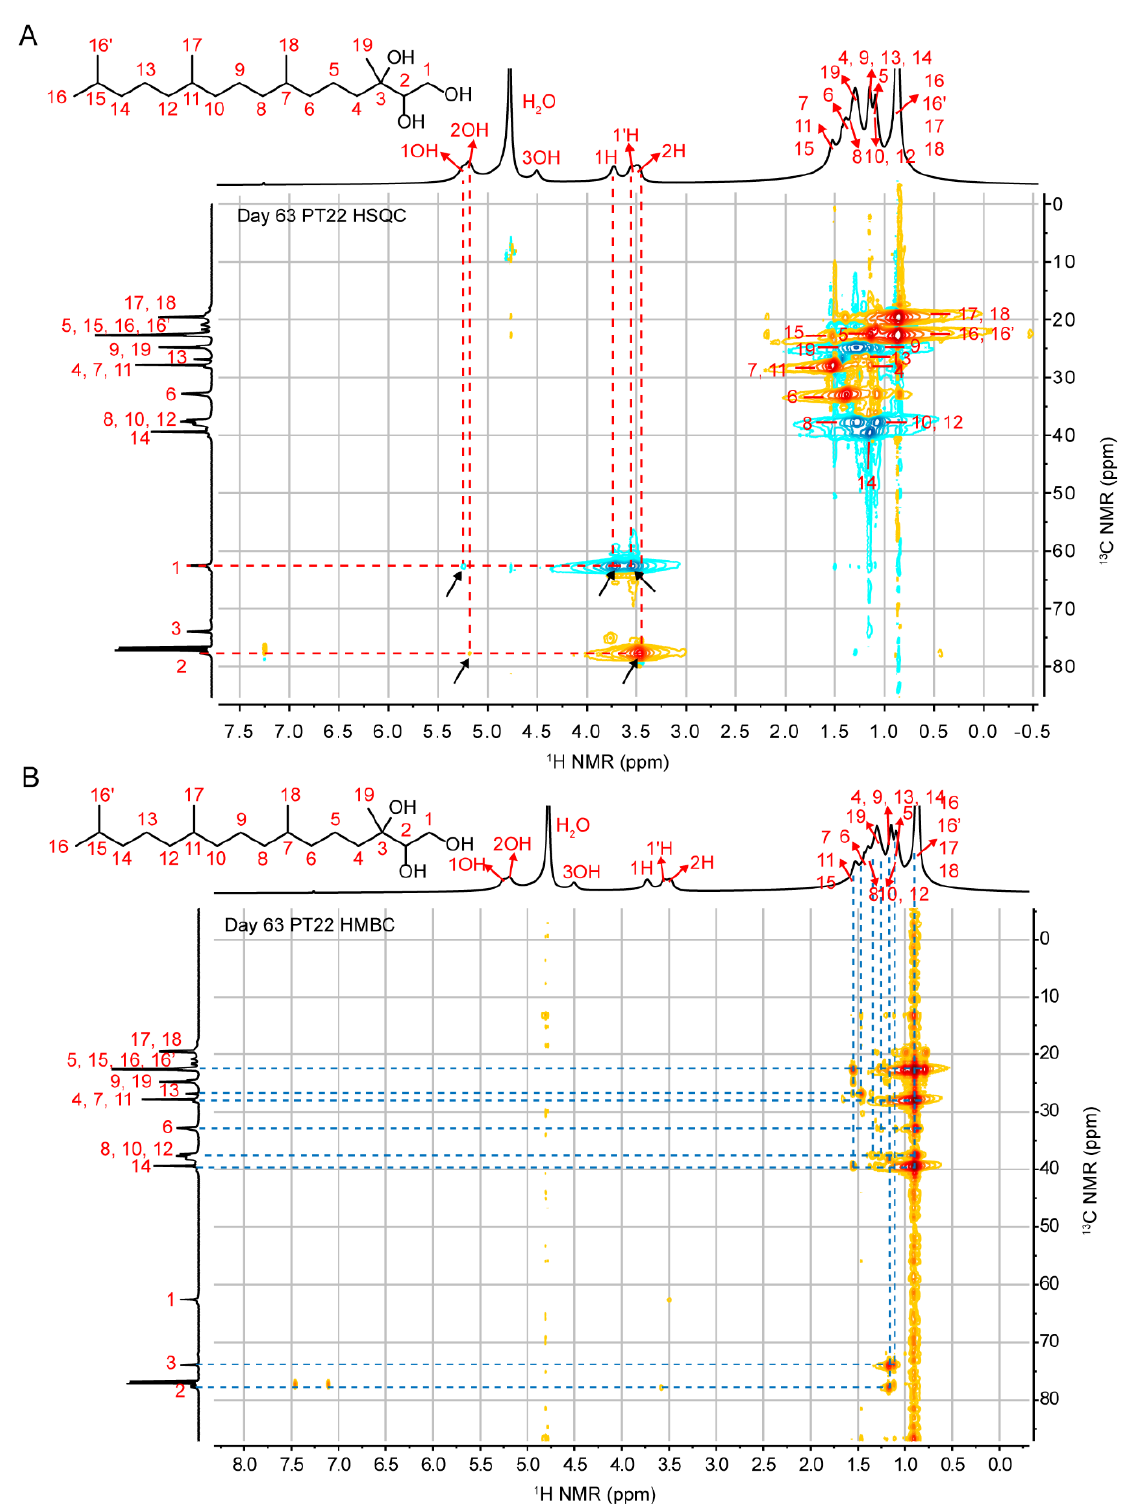
Figure 2. ( A ) 1 H— 13 C HSQC spectrum and ( B ) remotely coupled 1 H— 13 C HMBC spectrum of PT22 (22% wt H 2 O) acquired at day 63. Table 1. 1 H and 13 C-{ 1 H} chemical shift attributions of PT22 at 298 k, day 63.